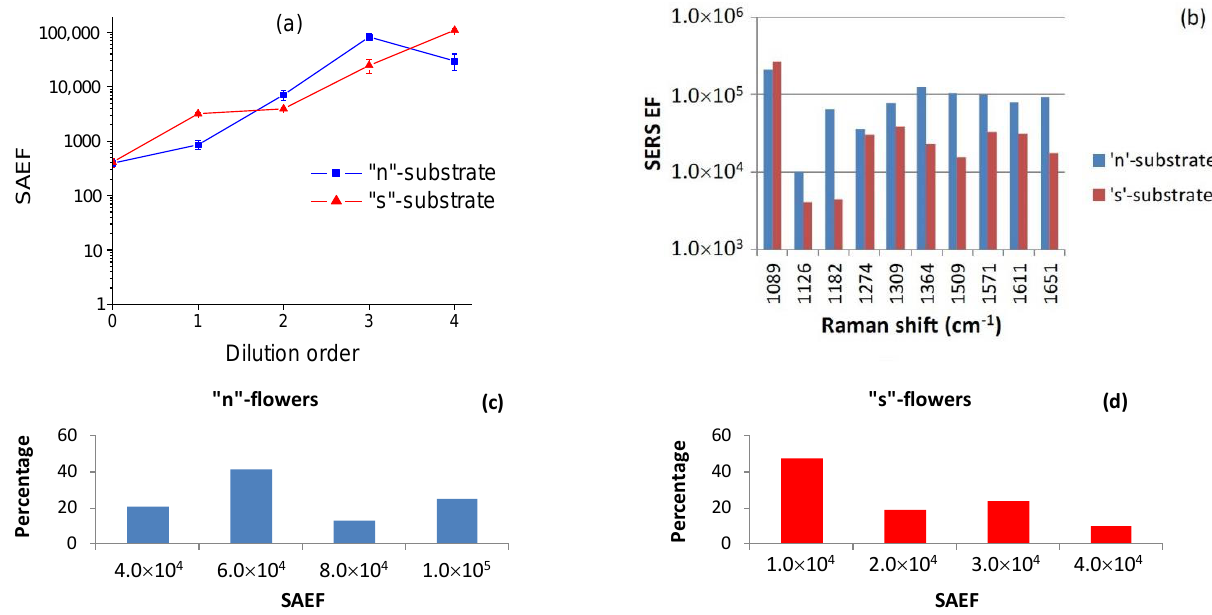
Figure 5. ( a ) Spectrum-averaged enhancement factor (SAEF) for ‘n’- and ‘s’-substrates treated with R6G solutions of different concentrations. ( b ) SERS enhancement factors for different R6G modes on silver flowers treated in a 10 − 6 M solution. Histograms of SAEF recorded on different silver flowers treated in a 10 –6 M solution: ‘n’-flowers ( c ) and ‘s’-flowers ( d ).